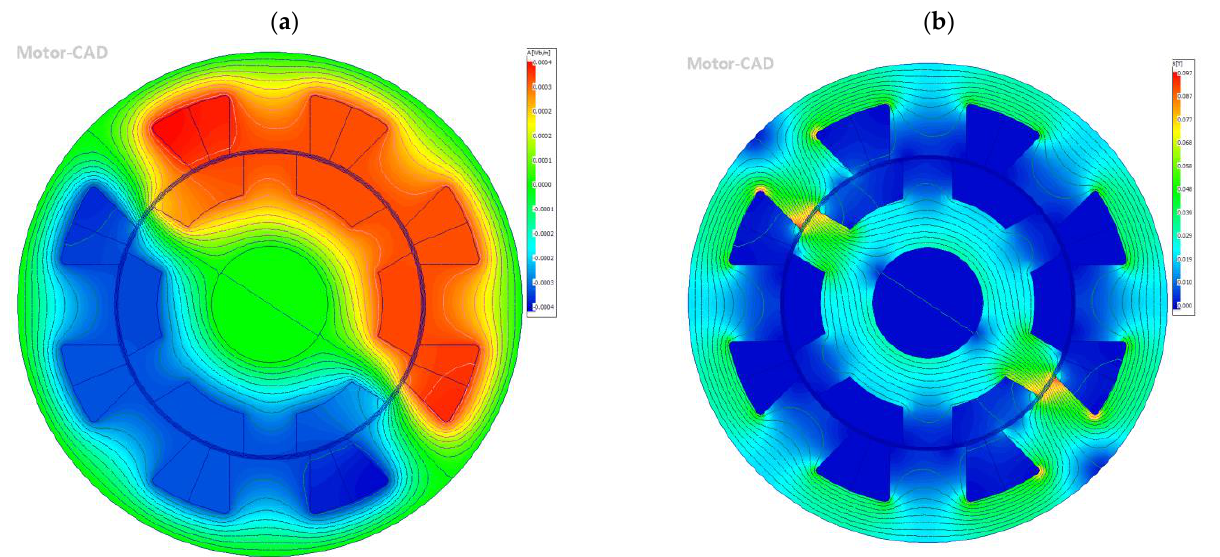
Figure 17. Magnetic properties simulations of an 8/6 motor: ( a ) magnetic flux density [Wb/m 2 ]; ( b ) magnetic induction [T].